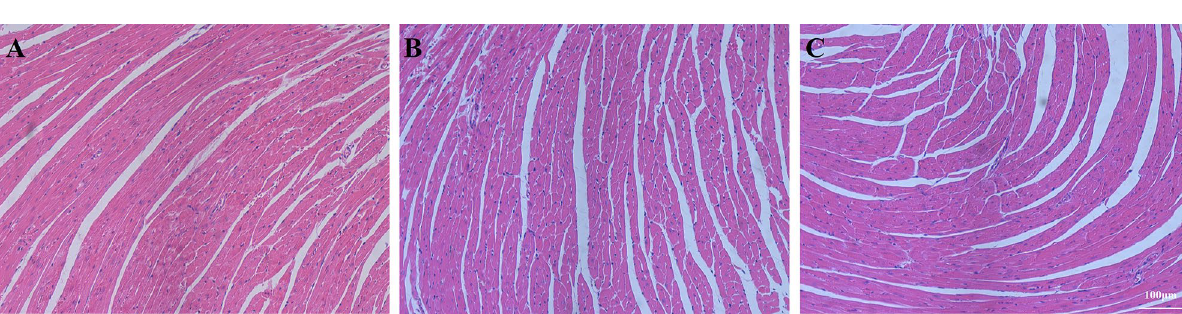
Figure 11. BM-MSCs improved LPS-induced kidney injury at 48 h after LPS treatment. ( A ) Sham group. ( B ) LPS group. ( C ) LPS + MSC group. ( A – C , ×100 magnification. D – F , ×400 magnification).